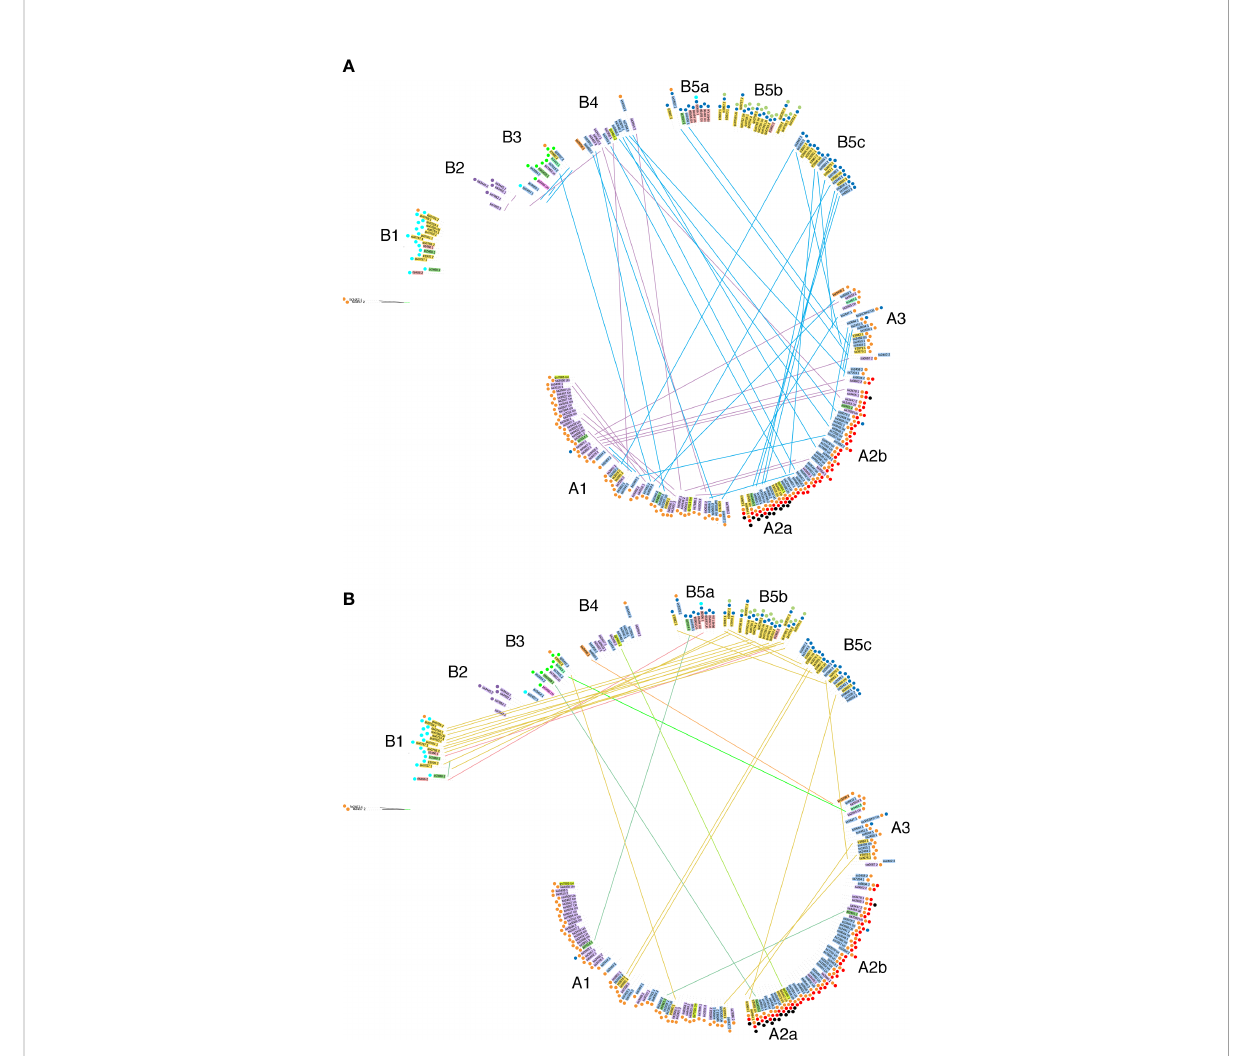
FIGURE 5 Localisation of paired alleles on the phylogenetic tree (same as in Figure 4) Paired alleles are connected by lines, with the same species color code as in Figure 4. Several pairs have one member in group (A) , the other one in group (B)